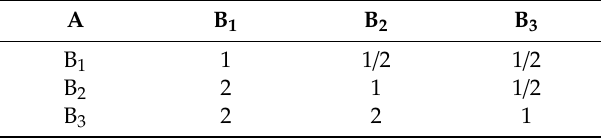
Table 10. Judgment matrix of the criteria layer (layer B).